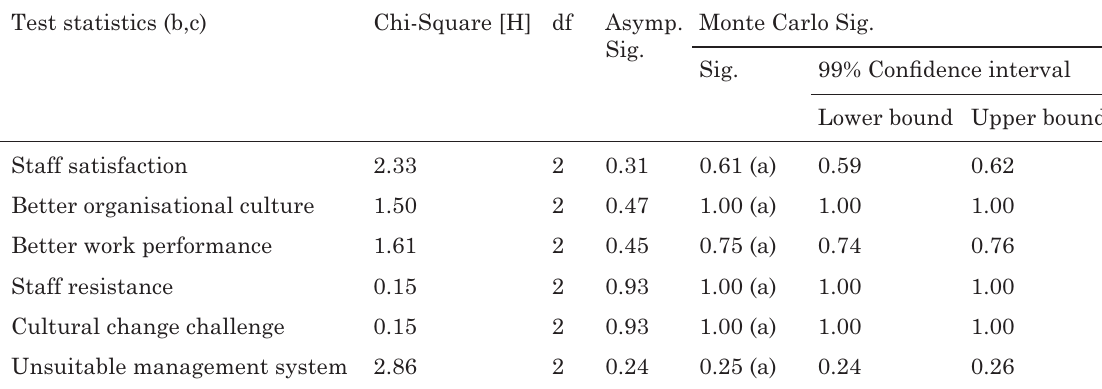
Table 8. Kruskal Wallis Test of Non-territorial working environment Test statistics (b,c) Chi-Square [H] df